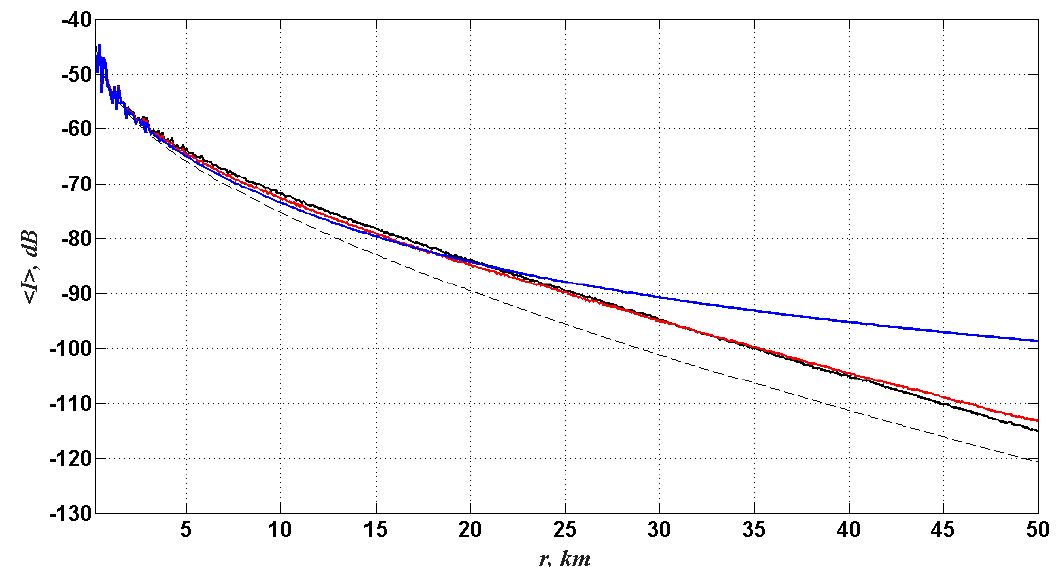
Figure 2. Transmission losses reported relative to intensity in a free field at a distance of 1 m from the source. Lower dashed curve corresponds to the intensity, averaged over spatial oscillations, for a deterministic waveguide model ( ε = 0). Blue curve demonstrates presence of two-dimensional Gaussian fluctuations of the speed of sound ε ( r , z ) in the waveguide with the scale L r = 50 km; red curve is L r = 5 km, black curve is L r = 1 km. Vertical scale is L z = 10 m; H − z = 26 m, H − z 0 = 42 m. As a result, the level of average intensity gradually rises above the level of averaged (over spatial oscillations) intensity corresponding to deterministic propagation conditions (dashed curve).